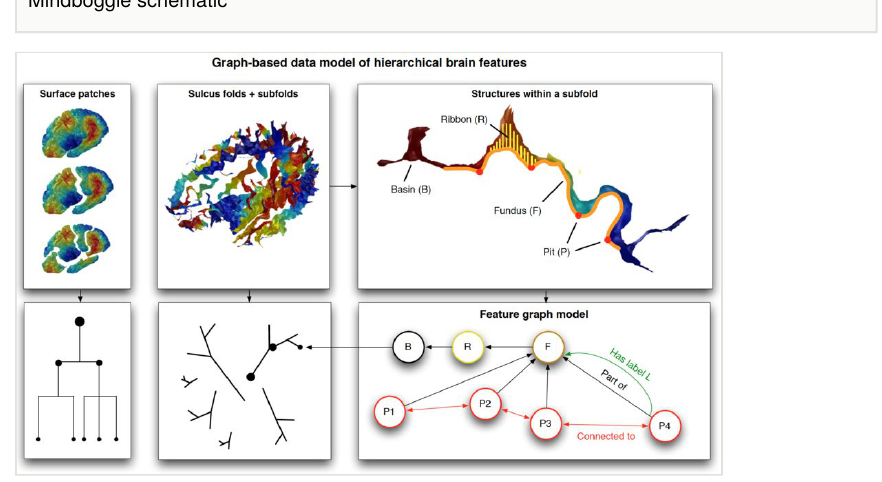
Our features are nested as follows: sulcal pits (points) lie along sulcal fundus curves, which lie along the depths of sulcal basins. Mindboggle stores the nested features as graphs in a Neo4j database that uses a graph-based data model as opposed to a standard relational database (Fig. 2). The primary advantage of nested, hierarchical features is that we can prioritize (or weight) the in fl uence of the features on comparison, matching, or diagnosis in